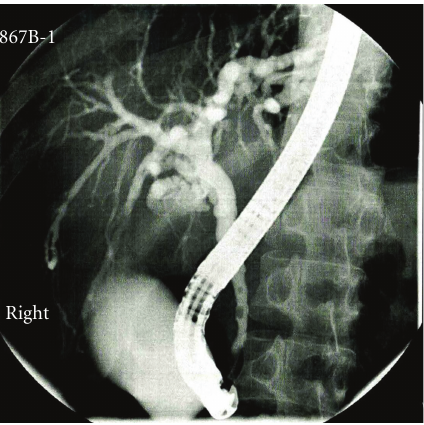
Figure 1: ERCP showing irregular wall contours, variable intrahep- atic stenoses, and two distal common bile duct stones.